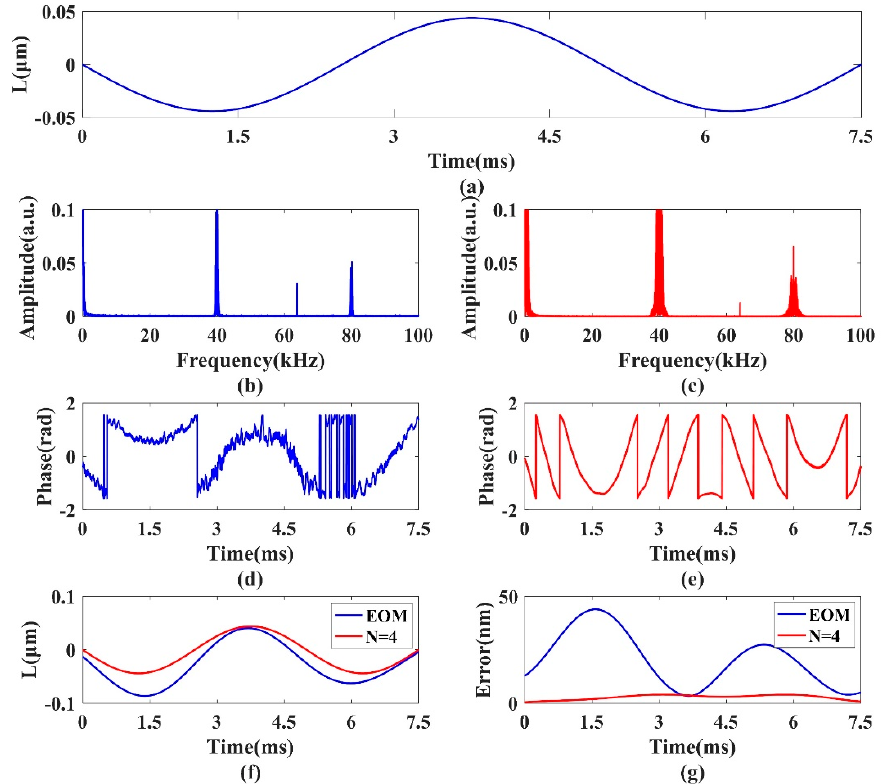
Figure 7. Experimental results of different methods with the driving voltage 0.1 V of target. ( a ) Vi- bration displacement of the outer objective. ( b ) Frequency spectrum of SMI signal using EOM-PM. ( c ) Frequency spectrum of SMI signal using MR-PM. ( d ) Wrapped phase from SMI of EOM-PM. ( e ) Wrapped phase from SMI of MR-PM. ( f ) Reconstructed displacement of EOM-PM and MR-PM. ( g ) Displacement reconstruction error of EOM-PM and MR-PM.